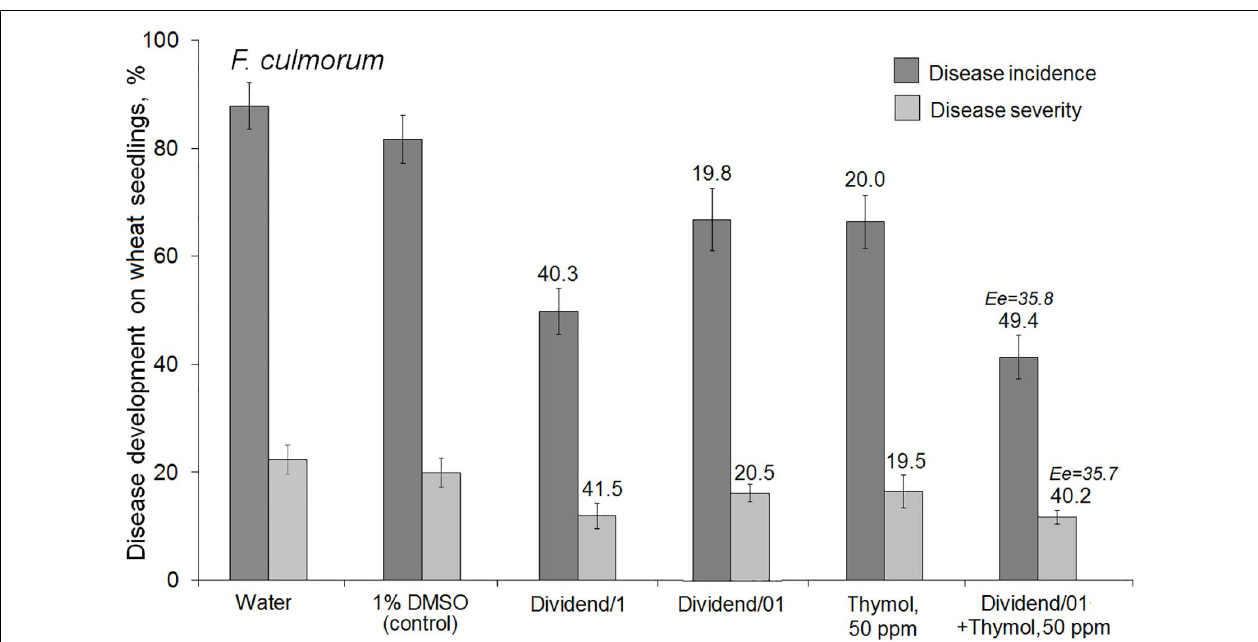
FIGURE 2 | Influence of seed treatments with Dividend R (cid:13) alone, thymol alone or their combination on the development of Fusarium root on spring wheat seedlings (cv. Zlata) from seeds artificially inoculated with F. culmorum . Dividend/1 and Dividend/01, the fungicide dosage recommended for industrial seed treatments and tenfold-lower dosage, respectively. Numbers above columns show Er values, while an expected additive effect (Ee) is indicated with italic numbers. The means of three independent roll-towel assays ( n = 200 seeds per treatment in each assay). Y-bars show SE ( p ≤ 0.05). For additional explanations, see caption to Figure 1 and section “Materials and Methods,” “Data Analysis and